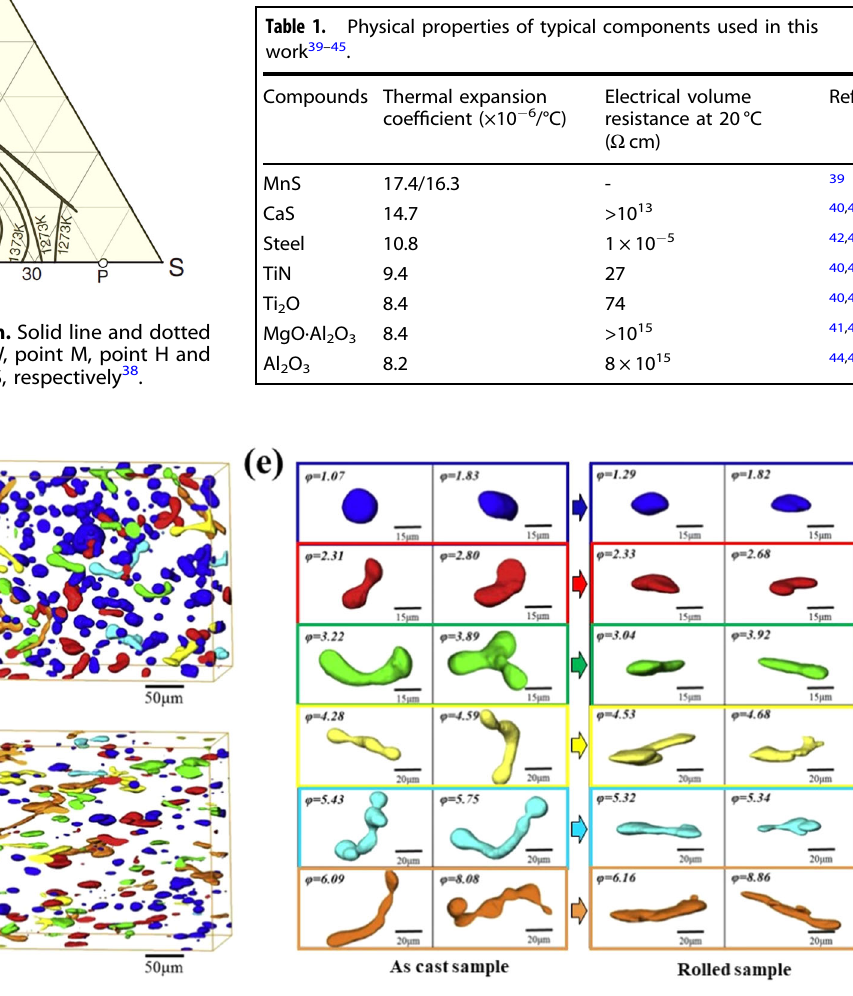
Fig. 3 Comparison of the shape factor distribution of two-types of MnS inclusions. a Statistical and b typical spatial distribution of MnS inclusions in as-cast sample. c Statistical and d spatial distribution of MnS inclusions in samples in the same spatial region after tensile deformation. e Typical Morphology of different types of MnS inclusions before and after deformation. Note that inclusion particles in the fi gures are colored by the individual identi fi cation number for the convenience of illustration 47 .